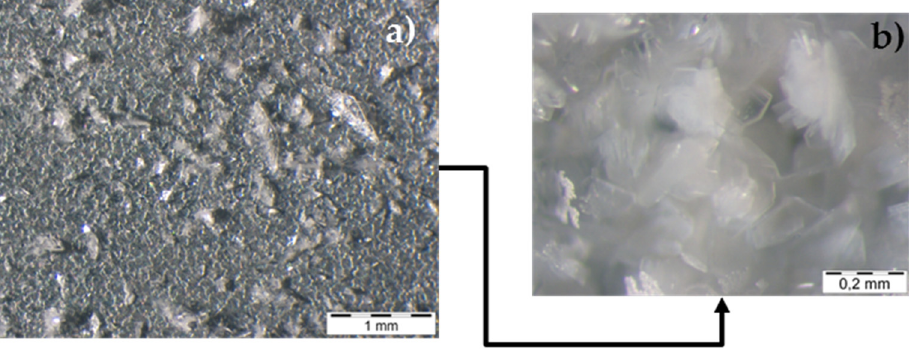
Figure 6. Stereoscopic observation of the corrosion products formed on HDGS during immersion in highly alkaline solution. ( a ) Generic view and ( b ) detail of the morphology of the calcium hydroxyzincate crystals formed.